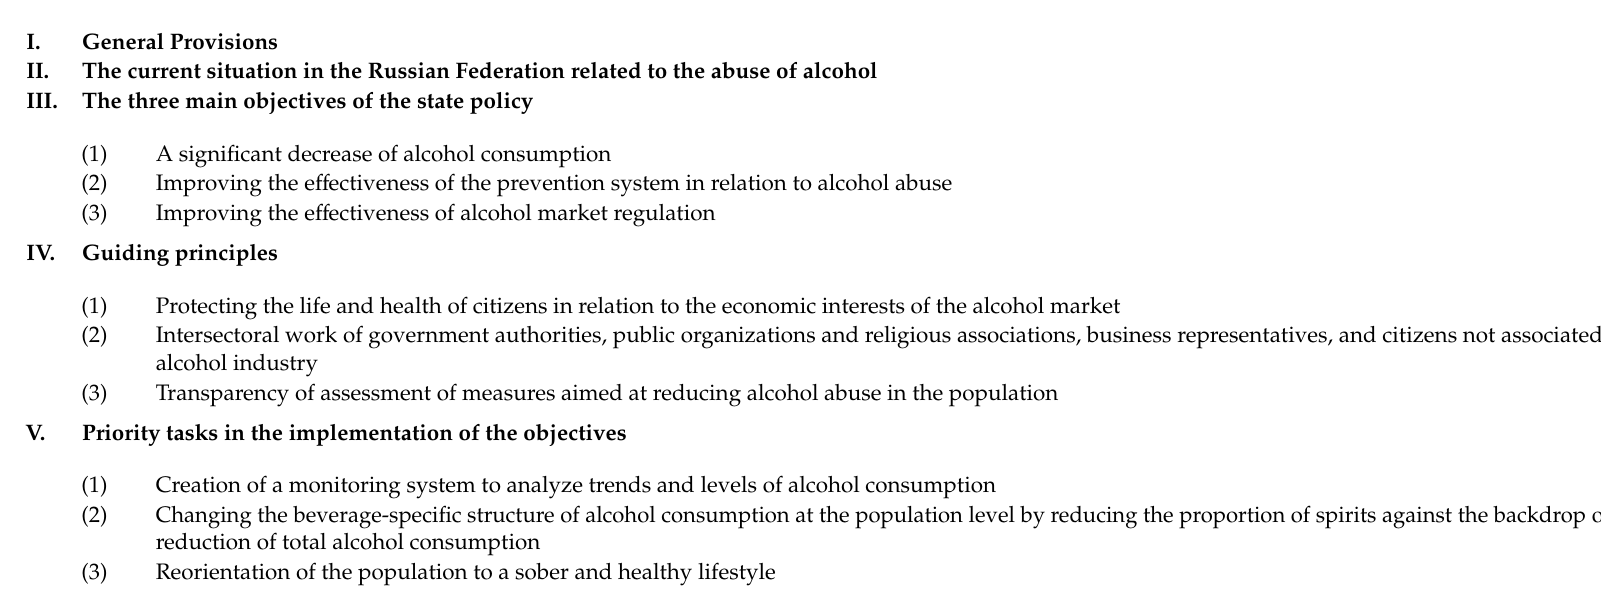
Table A1. Outline of the core components of the Russian 2010–2020 alcohol